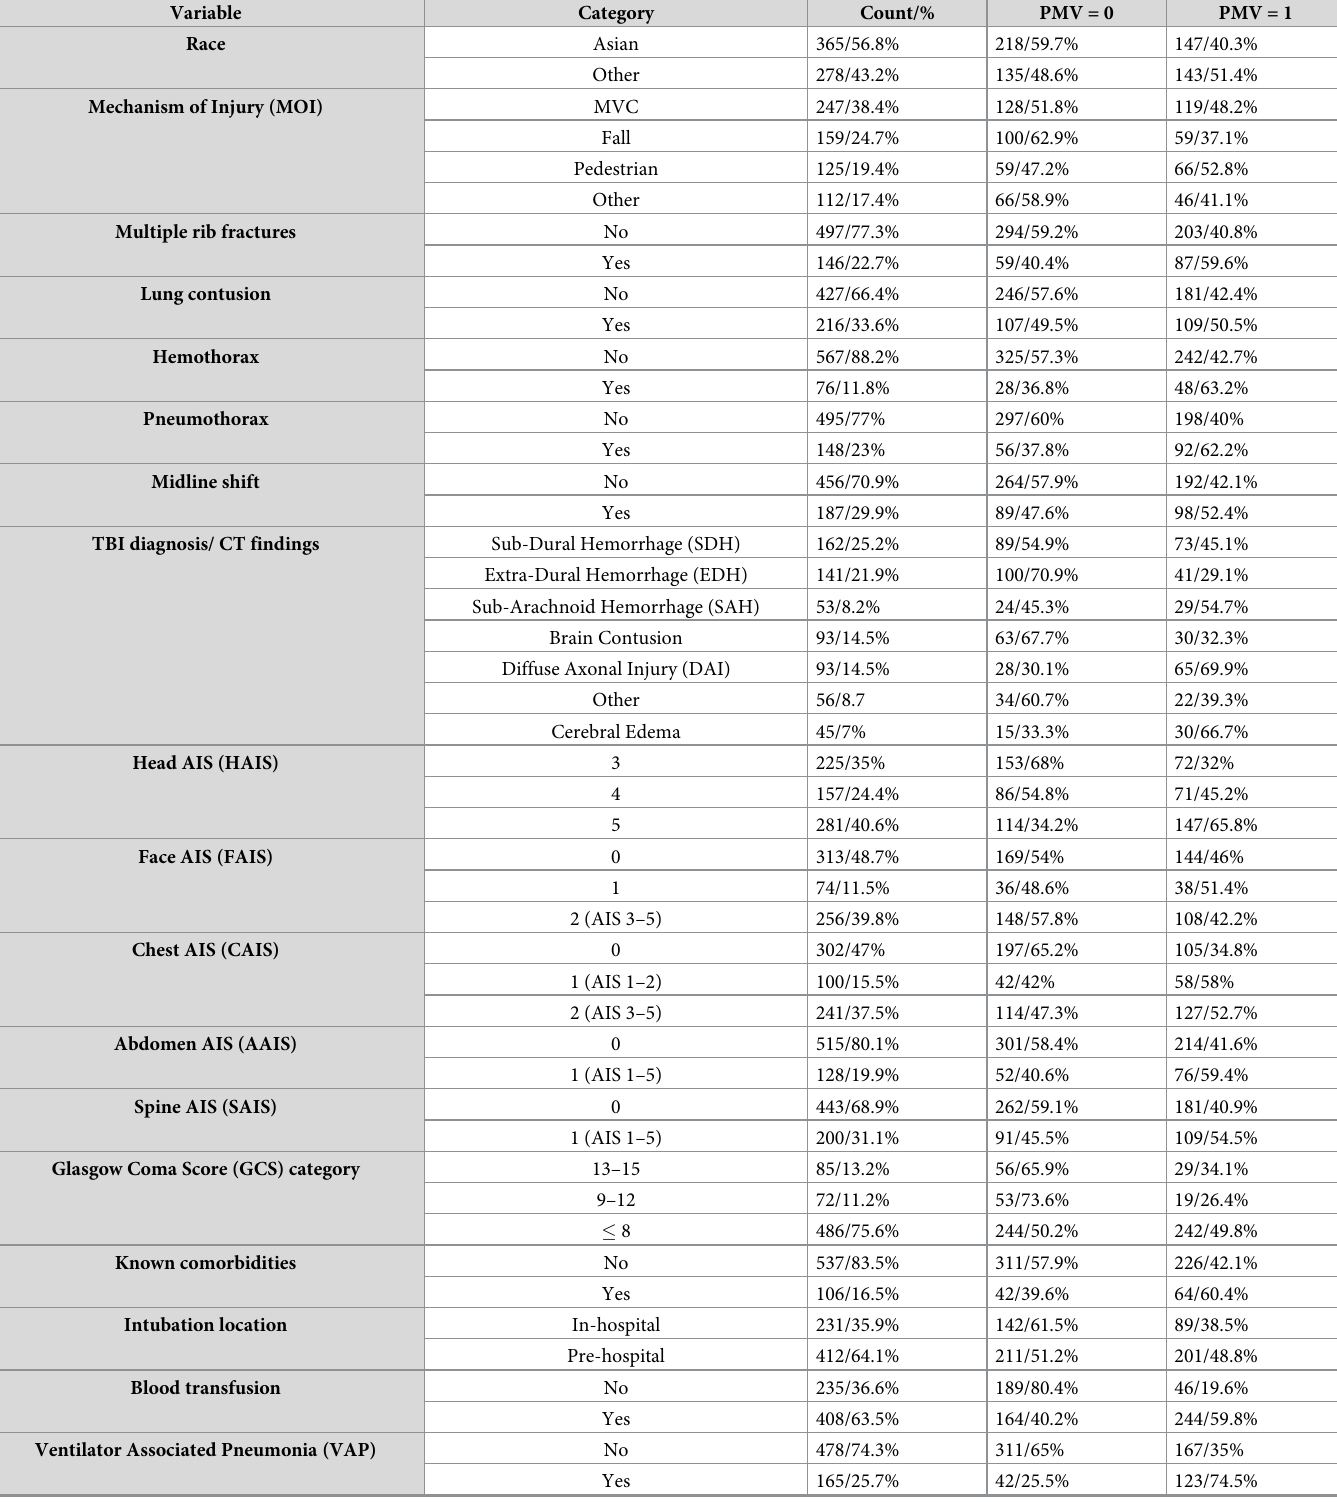
Table 4. Sample characteristics (set B)—nominal and ordinal